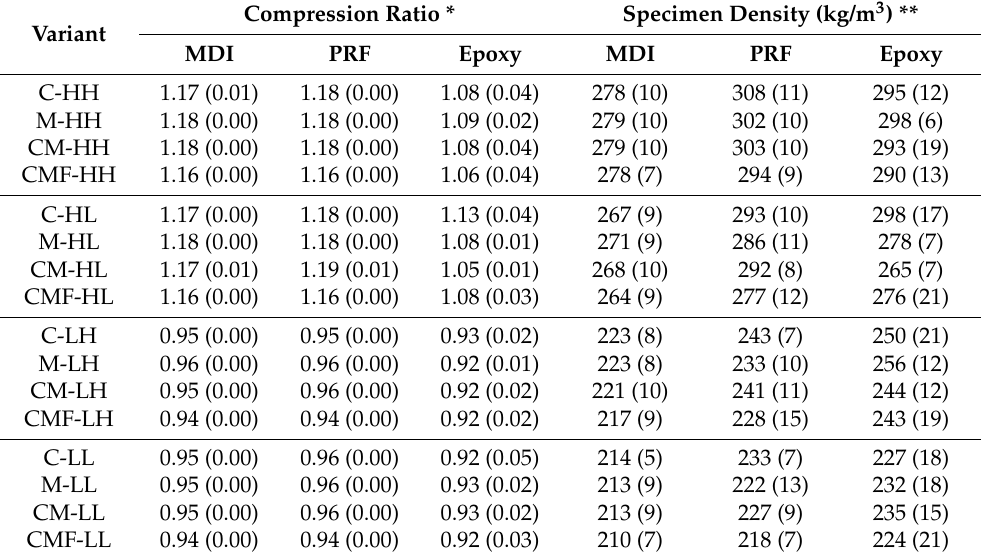
Table 7. Compression ratios of ultra-low-density hemp particleboard and resulting IB specimen densities per variant and adhesive type.